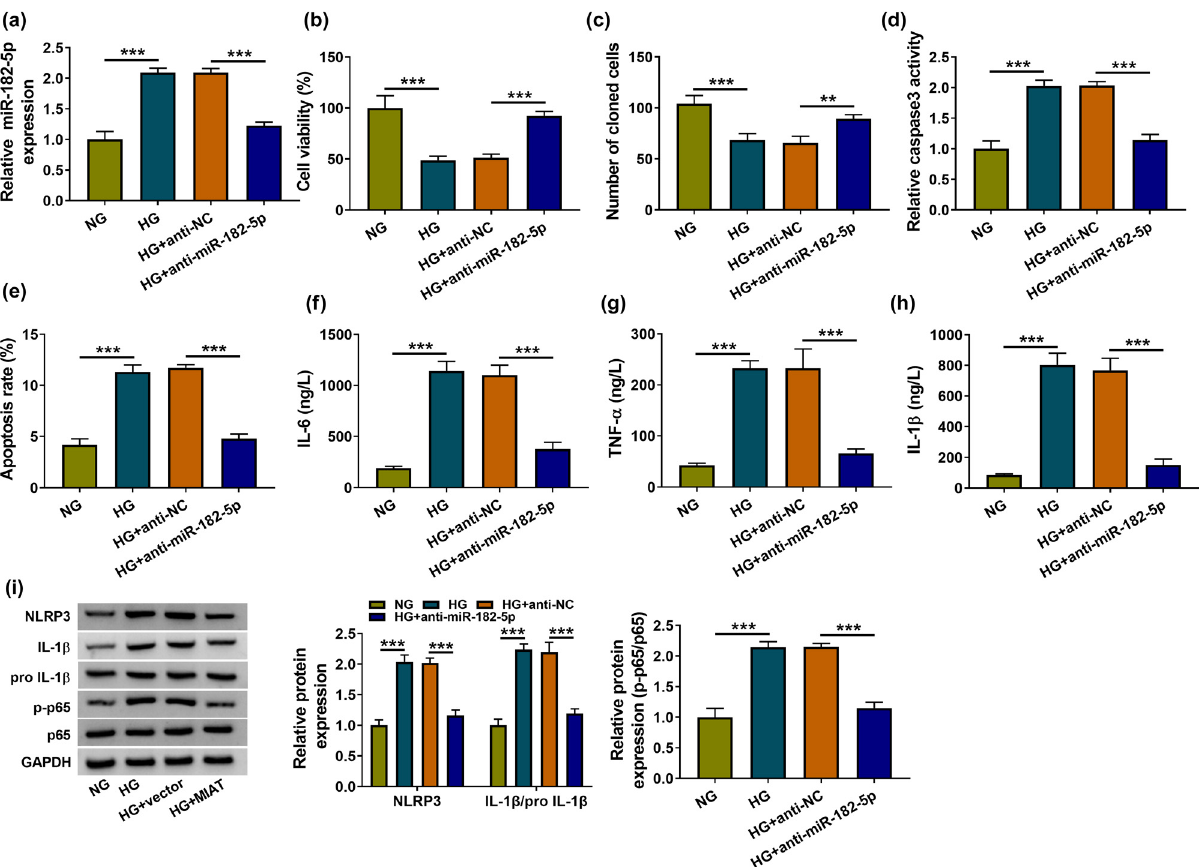
Figure A2: Inhibition of miR - 182 - 5p reduced the HG - induced toxicity in HK - 2 cells. HK - 2 cells were treated with NG, HG, HG + anti - NC or HG + anti - miR - 182 - 5p. ( a ) The miR - 182 - 5p expression was determined by RT - qPCR. ( b – c ) Cell viability ( b ) and colonizing capacity ( c ) were respectively measured using CCK - 8 and colony formation assay. ( d – e ) Caspase 3 assay ( d ) and fl ow cytometry ( e ) were performed to assess cell apoptosis. ( f – h ) The concentrations of in fl ammatory cytokines were detected via ELISA. ( i ) The proteins of in fl ammation and NF - κ B pathway were assayed by western blot. ** P < 0.01, *** P < 0.001.